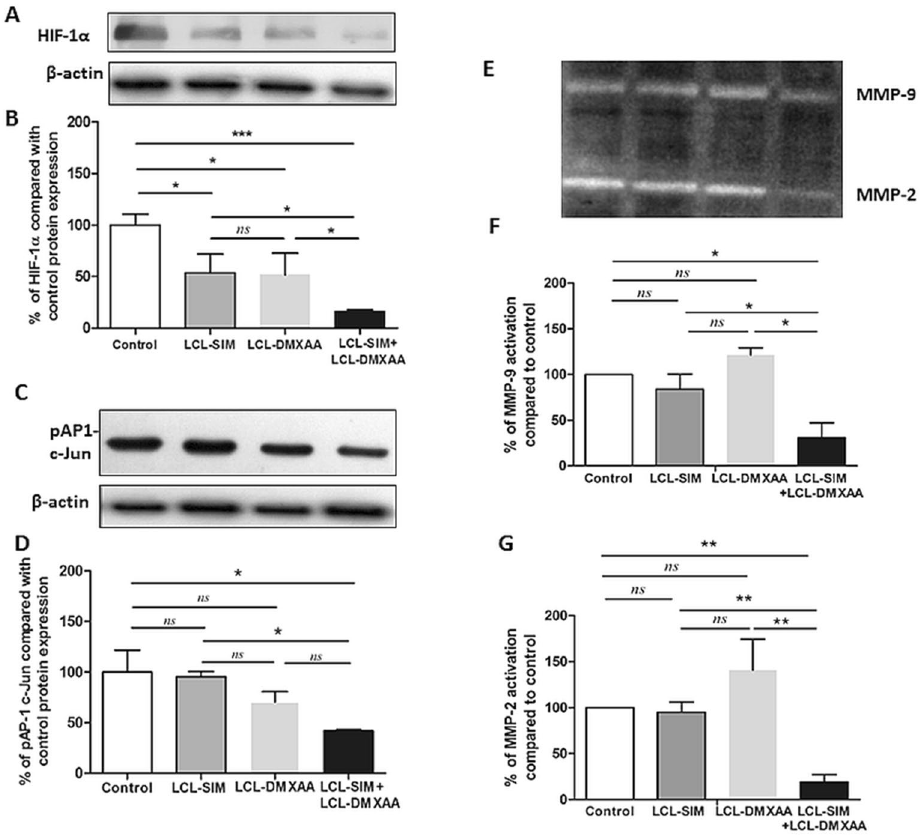
Figure 6. Effects of liposome-encapsulated SIM and DMXAA on intratumoral levels of key invasion and metastasis promoters. ( A ), ( C ) Western blot analysis showing the effects of different treatments on the intratumor levels of HIF-1α and pAP-1 c-Jun, respectively. β-actin was used as loading control. ( B ), ( D ) Protein levels of HIF-1α and pAP-1 c-Jun in lysates from treated groups expressed as percentage from Control—LCL- treated group. Data represent the mean ± SD of two independent measurements. One way ANOVA test with Bonferroni correction for multiple comparisons was performed to analyze the differences between the effects of the treatments on apoptotic proteins ( ns , P > 0.05; *, P < 0.05; ***, P < 0.001). ( E ), ( F ), ( G )—The effects of different treatments on the activity of microenvironmental matrix metalloproteinases. ( E ) Gelatin zymography analysis of tumor lysates from mice treated with various liposome-encapsulated SIM and DMXAA therapies. Coomassie blue staining highlights gelatinolytic activity corresponding to MMP-9 and MMP-2 (pro-froms and active forms). ( F ), ( G ) Percentage of MMP-9 and MMP-2 activity in tumor lysates from mice treated with single and combined SIM and DMXAA liposomal therapies compared to control. Data represent the mean ± SD of two independent measurements. One way ANOVA test with Dunnett correction was performed to analyze the differences between the effects of various treatments on MMP-9 and MMP-2 levels compared to control untreated group ( ns , P > 0.05; *, P < 0.05; **, P < 0.01). Control—LCL-treated group; LCL-SIM—experimental group treated with 5 mg/kg SIM as liposome-encapsulated form; LCL-DMXAA—experimental group treated with 14 mg/kg DMXAA as liposome-encapsulated form; LCL-SIM + LCL-DMXAA—experimental group treated with 5 mg/kg SIM and 14 mg/kg DMXAA as liposome-encapsulated forms. The uncropped images of HIF-1α, pAP-1 c-Jun and β-actin blots, as well as the uncropped gel showing MMP-9 and MMP-2 gelatinolytic activity are presented in Supplementary Information file. The graphs were generated using GraphPad Prism 9.2.0.332 (Serial number: GPS-2216002-E###-#####, MachineID: 3383874FBDD) (https:// www. graph pad. com/). Images were processed using open source IrfanView graphic viewer 64-bit Version 4.58 (https://